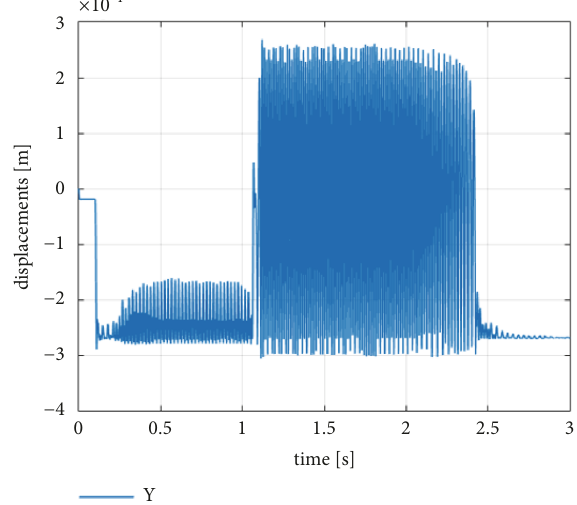
Figure28:PredictedrotorverticaldisplacementsatDEnodeduring a combined landing